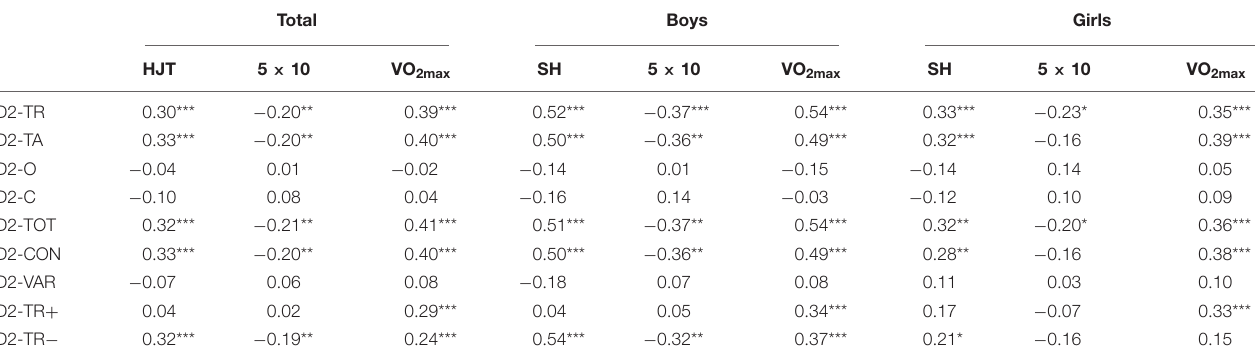
TABLE 2 | Correlation analysis among D2 test and physical fitness factors by gender and total sample. Total Boys